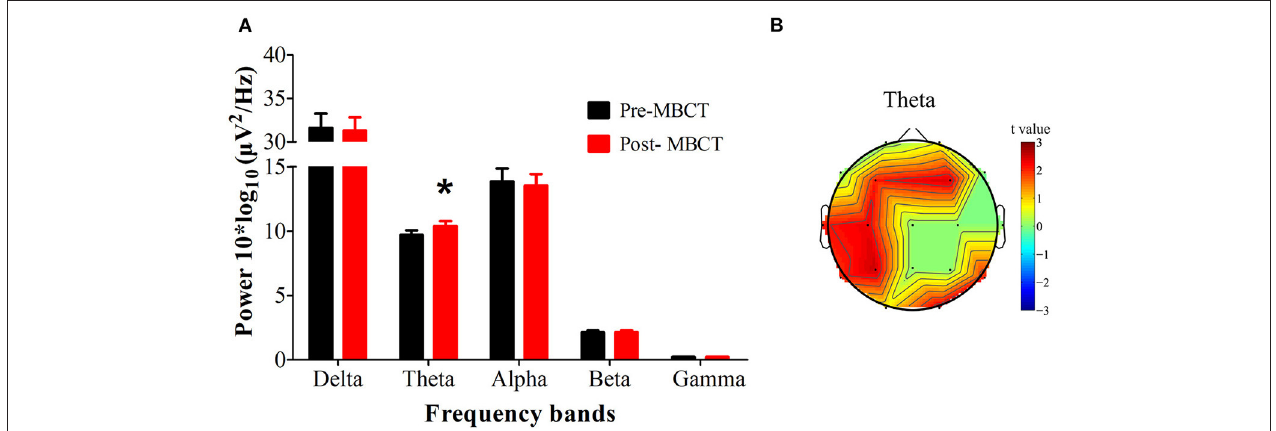
FIGURE 1 | Changes in the EEG power spectra after the 8-week MBCT intervention. (A) The average absolute EEG power in 5 frequency bands before (black columns) and after MBCT (red columns). The Y-axis represents power values, and the X-axis represents the frequency bands. A marked increase in power in the theta frequency was observed after intervention. * P < 0.05, FDR uncorrected. All data are expressed as the means ± SEM ( n = 26). (B) Topographic distribution of statistically significant theta power after MBCT compared to baseline before MBCT. Values are color coded: red = P < 0.05; green = not significant; uncorrected for the number of electrodes tested.